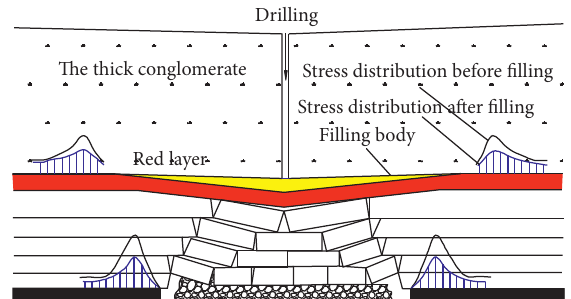
Figure 1: Schematic diagram of stress distribution before and after separation grouting.